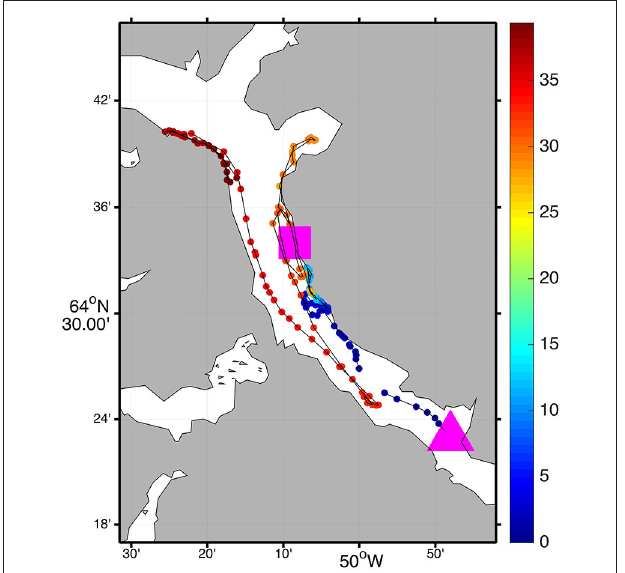
FIGURE 7 | A trajectory of an EXITE beacon initially deployed at the large pink triangle. Locations are color-coded according to time, in days, since deployment. Every 4th measurement is shown for clarity.